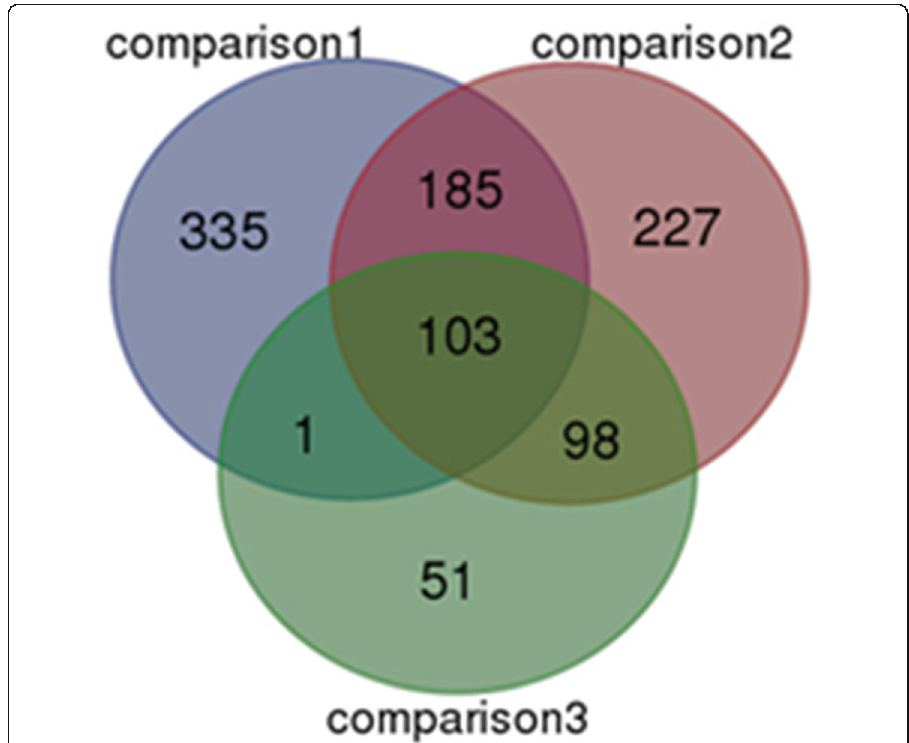
Fig. 1 Overlapping DEGs of macrophages from different S. aureus exposure times (Comparison 1, 2 and comparison